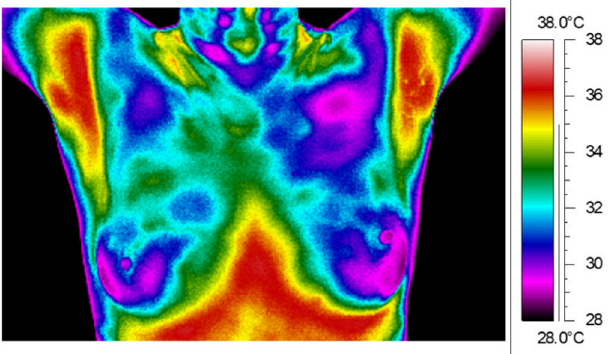
Figure 4. Thermal images for representative patient after mastectomy ( A ) and conserving surgery ( B ). The thermogram does not show any disproportions; it resembles a thermogram of a healthy patient (Figure 5).